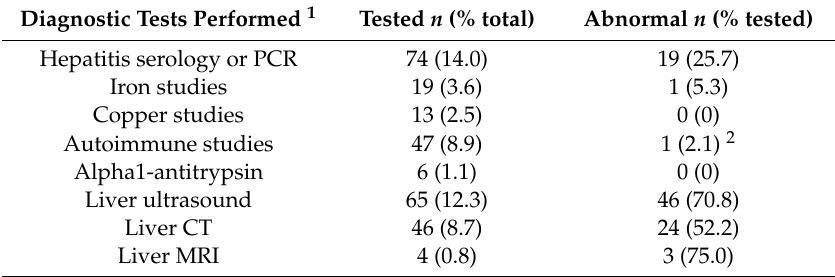
Table A3. Diagnostic tests to investigate abnormal liver function